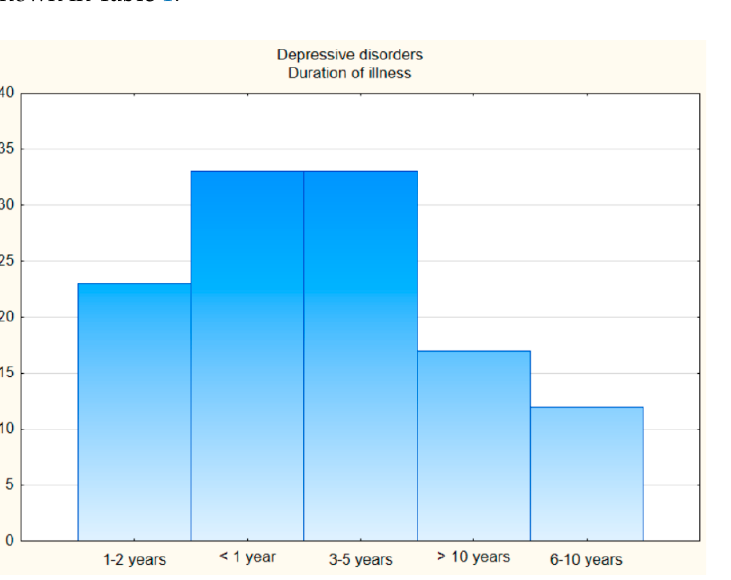
Figure 2. The duration of illness. The respondents completed the Stress Coping Questionnaire at the beginning of hos- pitalization. The COPE Inventory (multidimensional coping inventory) by C. S. Carver, M. F. Scheier, and J. K. Weintraub, in an adaptation by Z. Juczy ń ski and Ogi ń ska-Bulik, was used in the study. In 1989, Carver et al. [13] attempted to combine coping with stress understood as a style and as a strategy, referring to the transactional theory of stress and the self-regulation model of behavior. They proposed more than a dozen coping strategies which can reflect both a certain constant tendency and ways of dealing with a specific situation. To assess those strategies, they created the COPE (Coping Orientation to Prob- lems Experienced) Inventory. This self-description-based tool consists of 60 statements that are answered on a 4-point scale: 1 = I usually don’t do this at all; 2 = I usually do this a little bit; 3 = I usually do this a medium amount; 4 = I usually do this a lot. It allows 15 strategies for responding to stressful situations to be assessed. These strategies are: 1.